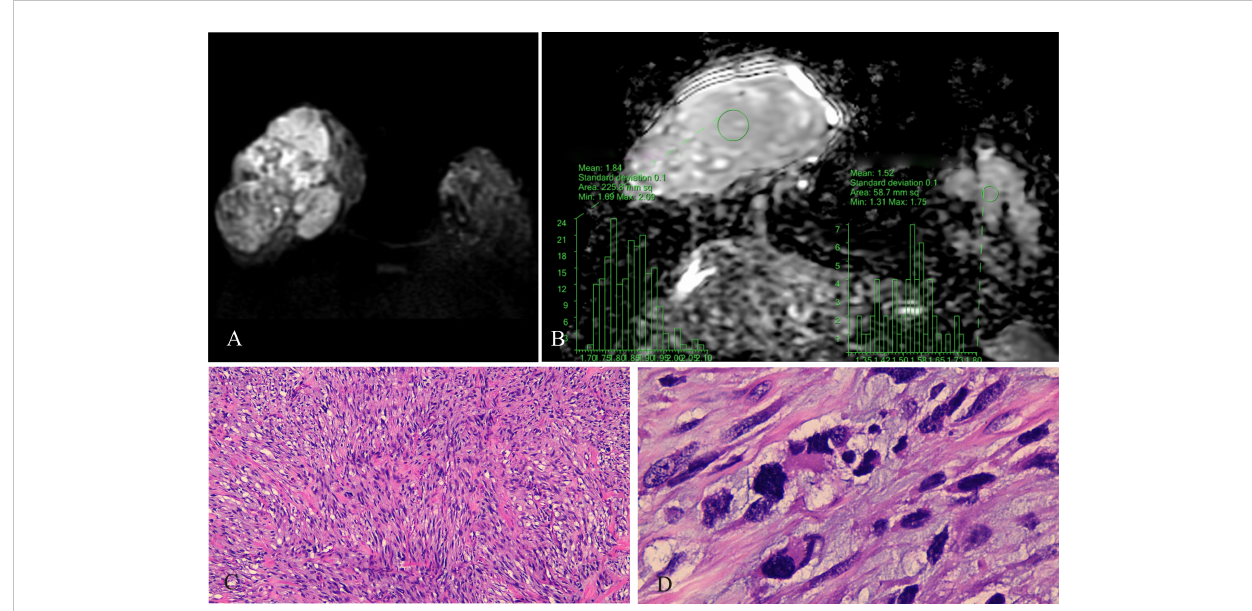
FIGURE 3 Malignant PT of the right breast, female, age 29 years. (A) DWI (b800 s/mm 2 ): mixed hyperintense signal; (B) ADC map: isointense-hyperintense mixed signal, ADCmean = 1.84 × 10 − 3 mm 2 /s; ADCmean (left normal breast) = 1.52 × 10 − 3 mm 2 /s; (C) HE ×100: tumor stromal cells were closely packed; (D) HE ×400: nuclear fi ssion, interstitial edema was insigni fi cant.